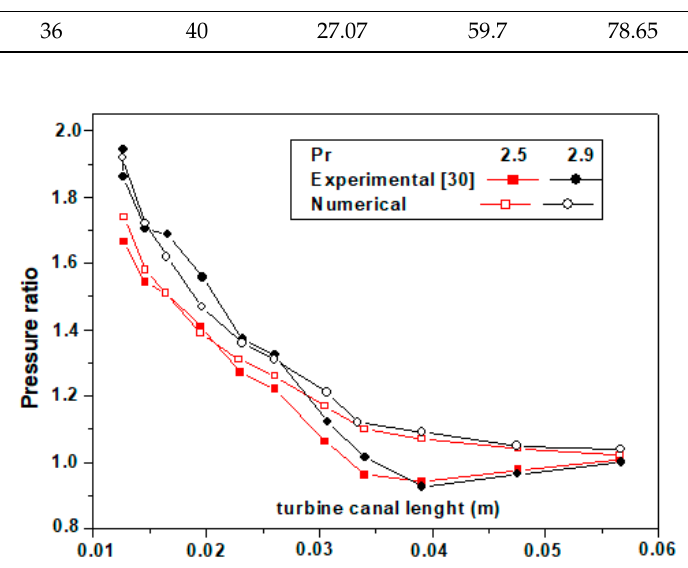
Figure 9. Numerical results validation [42].